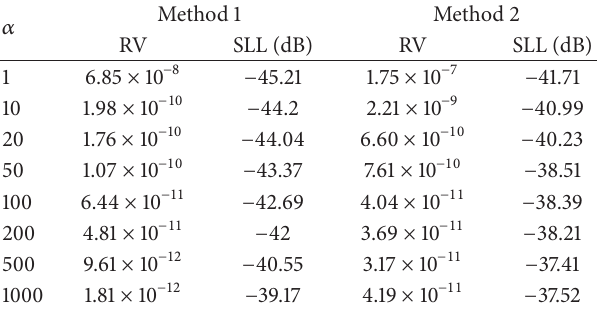
Table 2: Evaluation of the two proposed methods with different 𝛼 .